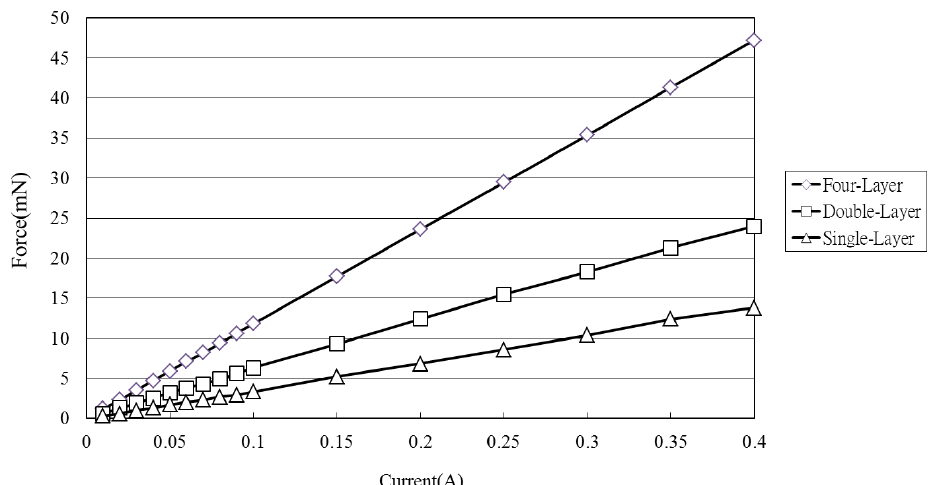
Figure 8. Variation of electromagnetic force with input current (0~0.4 A) at vertical 1 distance of 1.5 mm from surface of single-, double- and four-layer microcoil stacks.